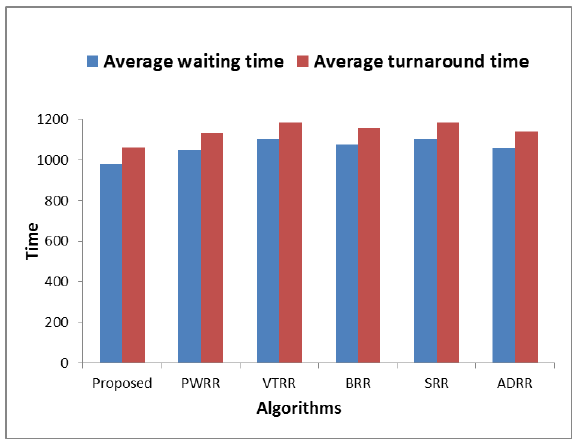
Figure 4. Comparing algorithms’ time cost.